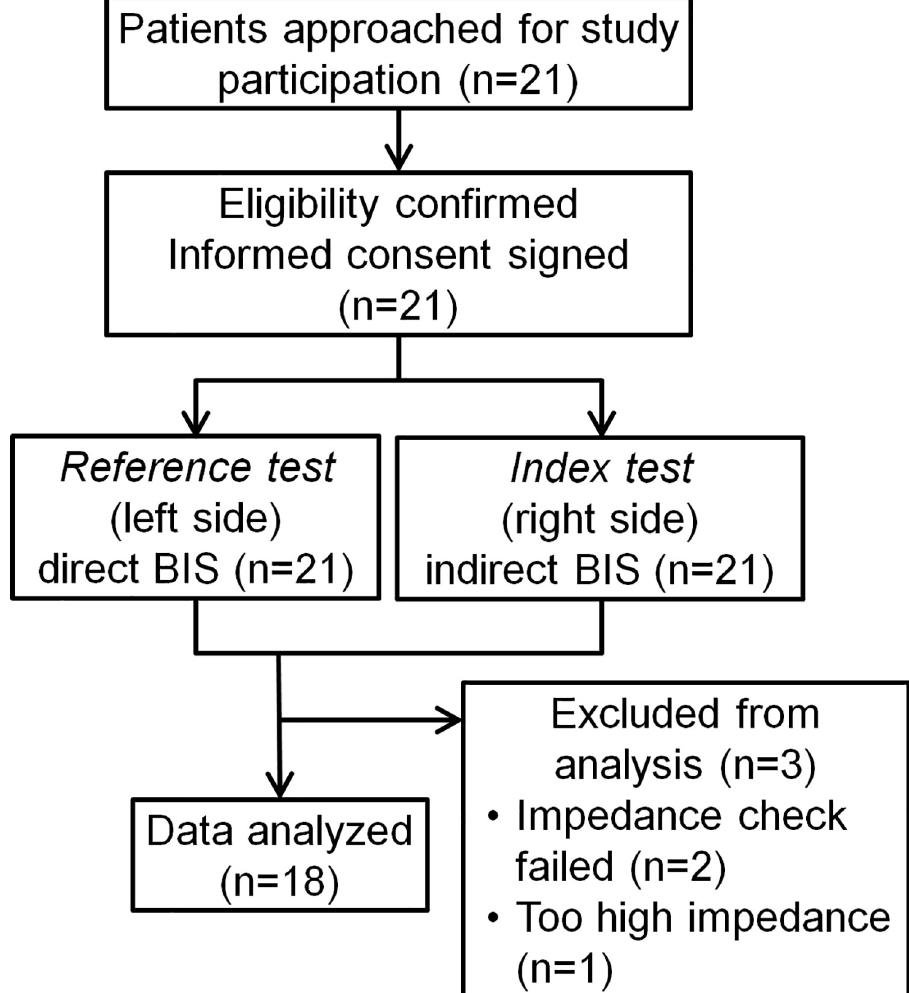
Fig 4. Flow of the participants in clinical study